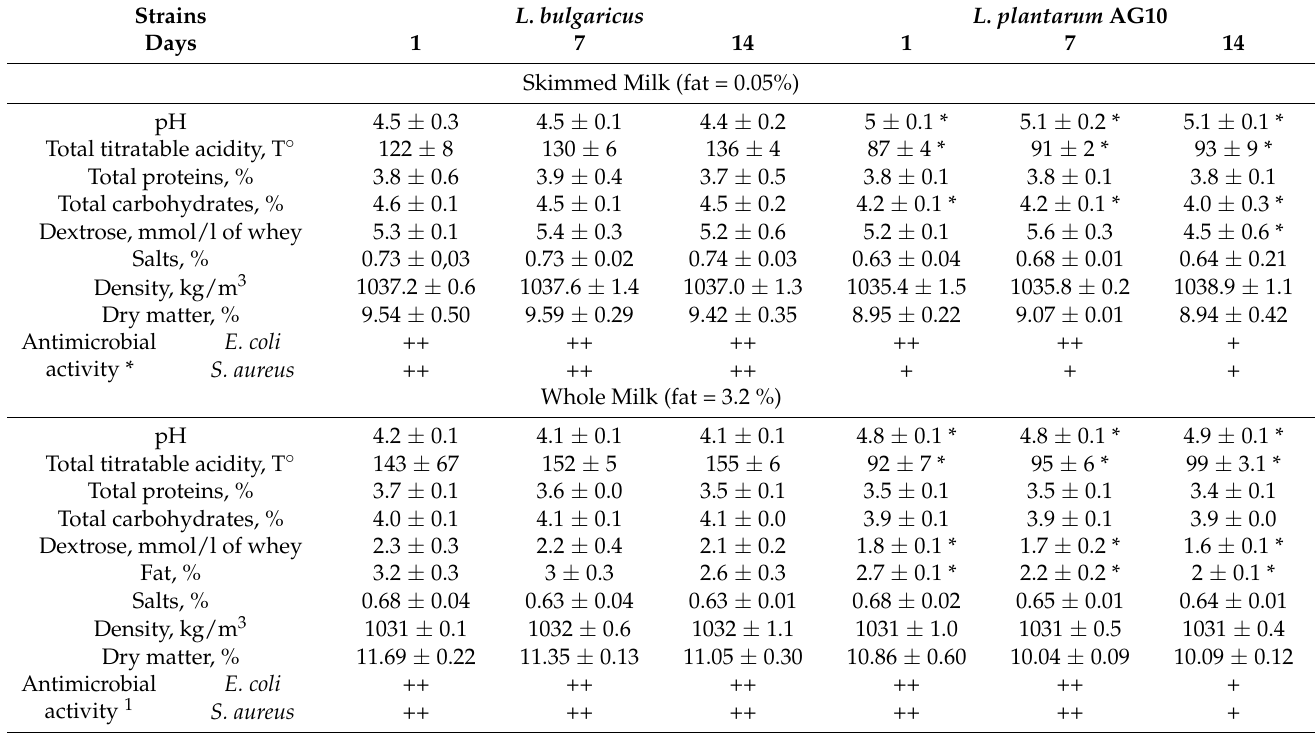
Table 1. Technological and physicochemical parameters of non-fat milk and whole milk fermented with L. bulgaricus or L. plantarum AG10 strains after 1, 7, and 14 days of storage at 4 ◦ C. Asterisks indicate a significant difference at p < 0.05 between strains. Mean values ± SD are shown (n =